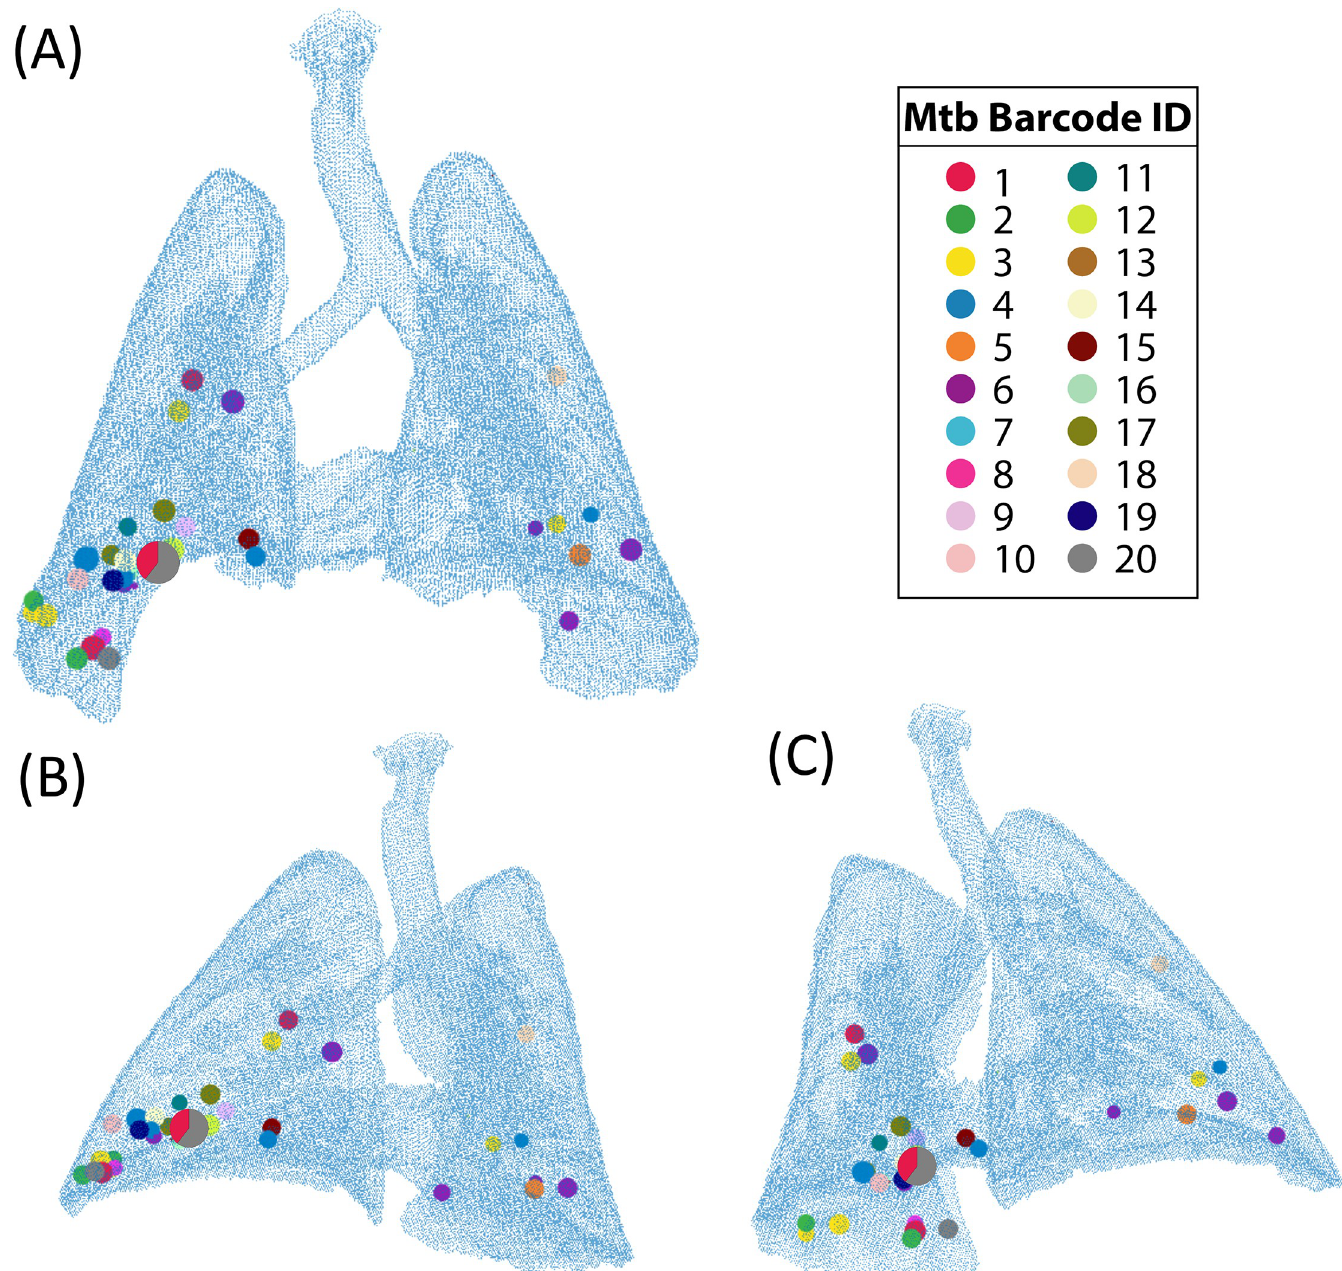
Fig 5. MultiGran in silico infection in a non-human primate lung. A single in silico simulation at 250 days post infection from three angles ( A -anterior view, B&C - opposite posterior-lateral views), plotted over a data grid taken from PET/CT images of a single NHP. Granulomas are located within the lung in 3D space. Each circle of a single color represents a granuloma or granuloma cluster with a single Mtb barcode ID. The circle shown as a pie chart represents a granuloma cluster with two unique Mtb barcode IDs; each color represents the relative proportion of CFU of each ID compared to the total CFU of the granuloma cluster, while the overall size of the circle is proportional to the size of the cluster. Inoculation was in the lower right lung (bottom left in each image). Granulomas found in the upper right lung and the left lung result from non-local dissemination within the simulation.